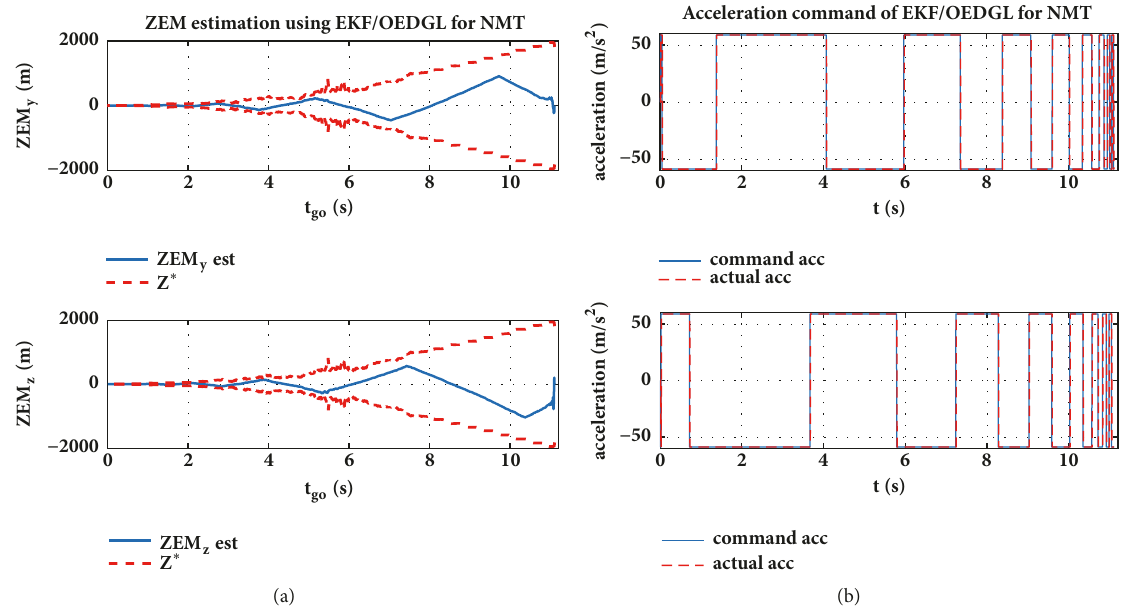
Figure 9: ZEM and acceleration commands of EKF/OEDGL for